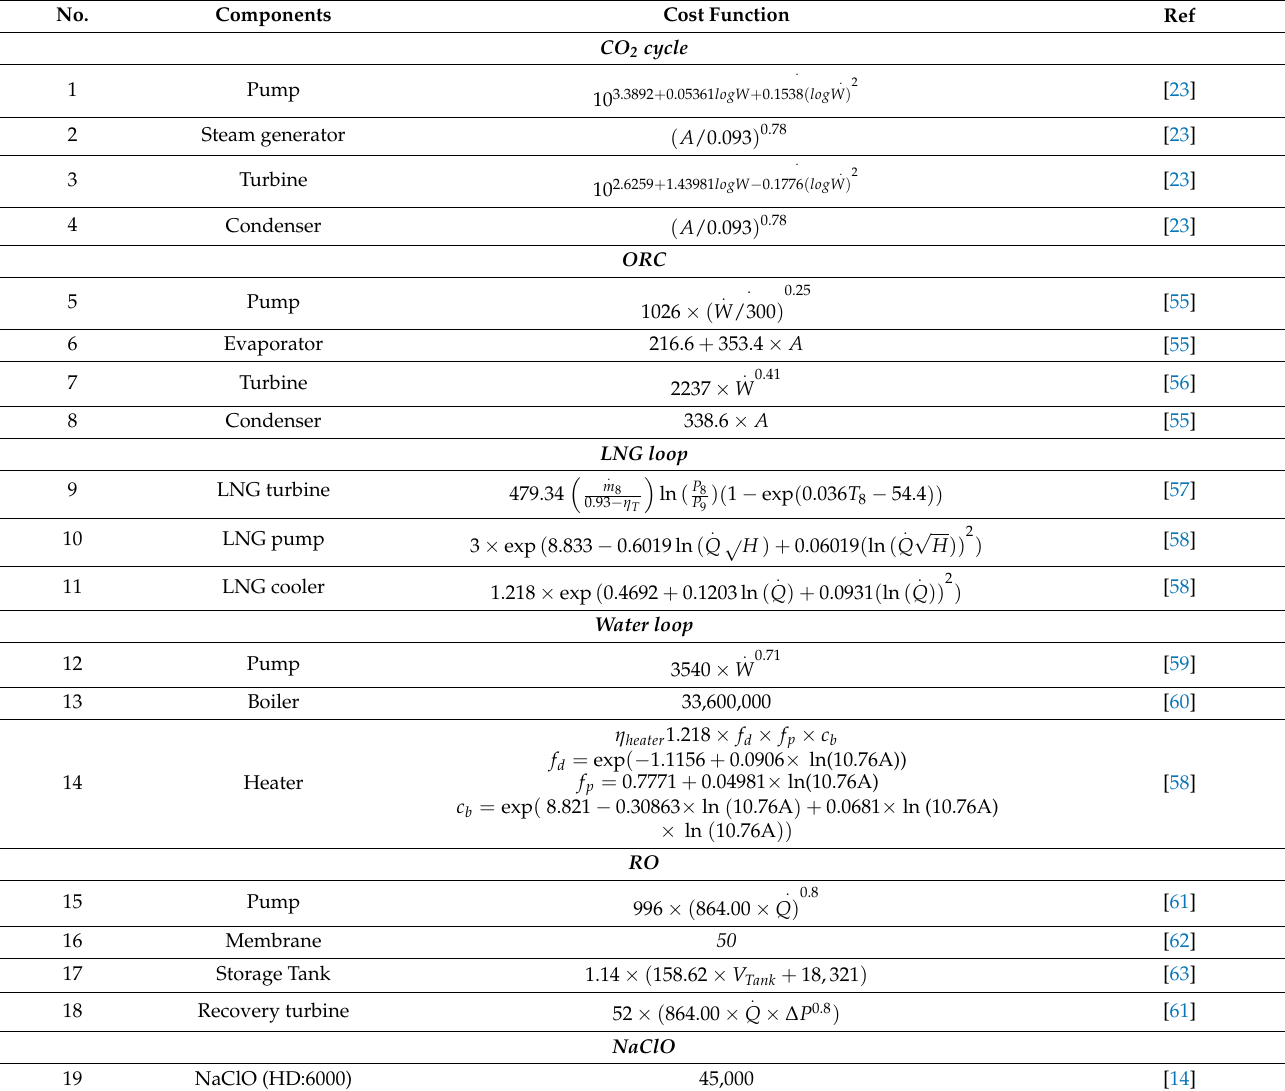
Table 7. Values of investment and installation costs for different